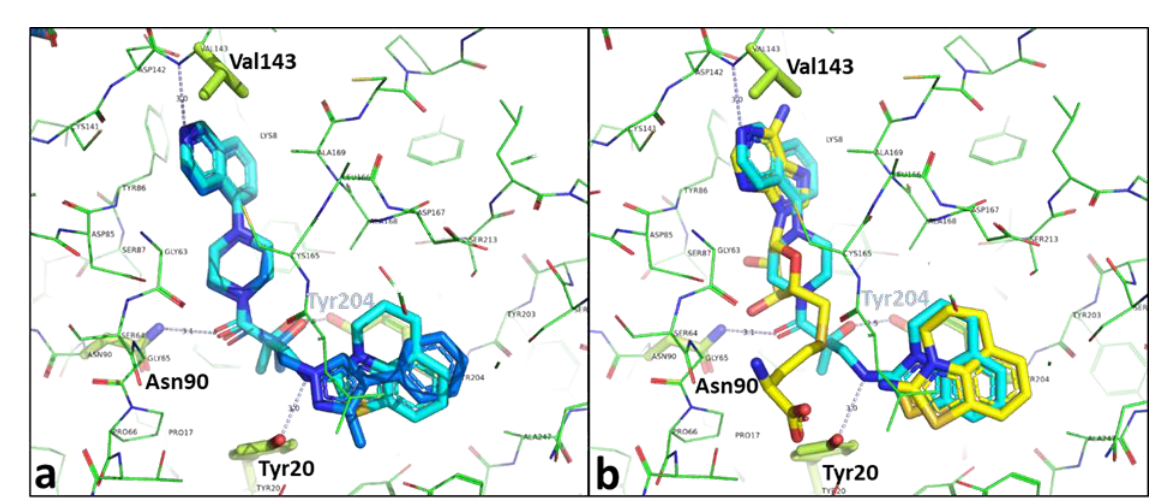
Figure 10. Crystal structure showing the binding mode of ( 33 ) (cyan) to hNNMT. ( a ) Comparison with the crystal structure of inhibitor ( 1 ) (blue). ( b ) Comparison with the crystal structure of the SAH and compound ( 2 ) complex (yellow).